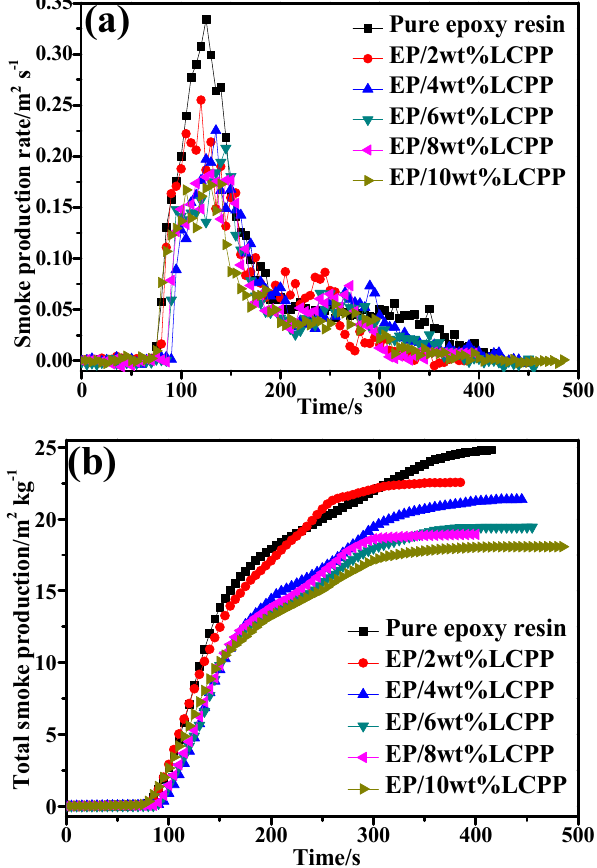
Figure 6. Smoke gas release of EP and the EP/LCPP composites; ( a ) SPR profiles; ( b ) TSP profiles. Figure 4b shows the THR profiles of pure EP and the EP/LCPP composites. The THR Table 3. Combustion parameters obtained from the cone calorimeter test. curves show that pure EP quickly releases a lot of heat and the THR value is as high as 92.5 MJ/m 2 . Meanwhile, with the introduction of 2, 4, 6, 8, and 10wt%LCPP into the EP, the THR values distinctly dwindle to 78.5, 78.8, 74.2, 62.3, and 60.8 MJ/m 2 , which